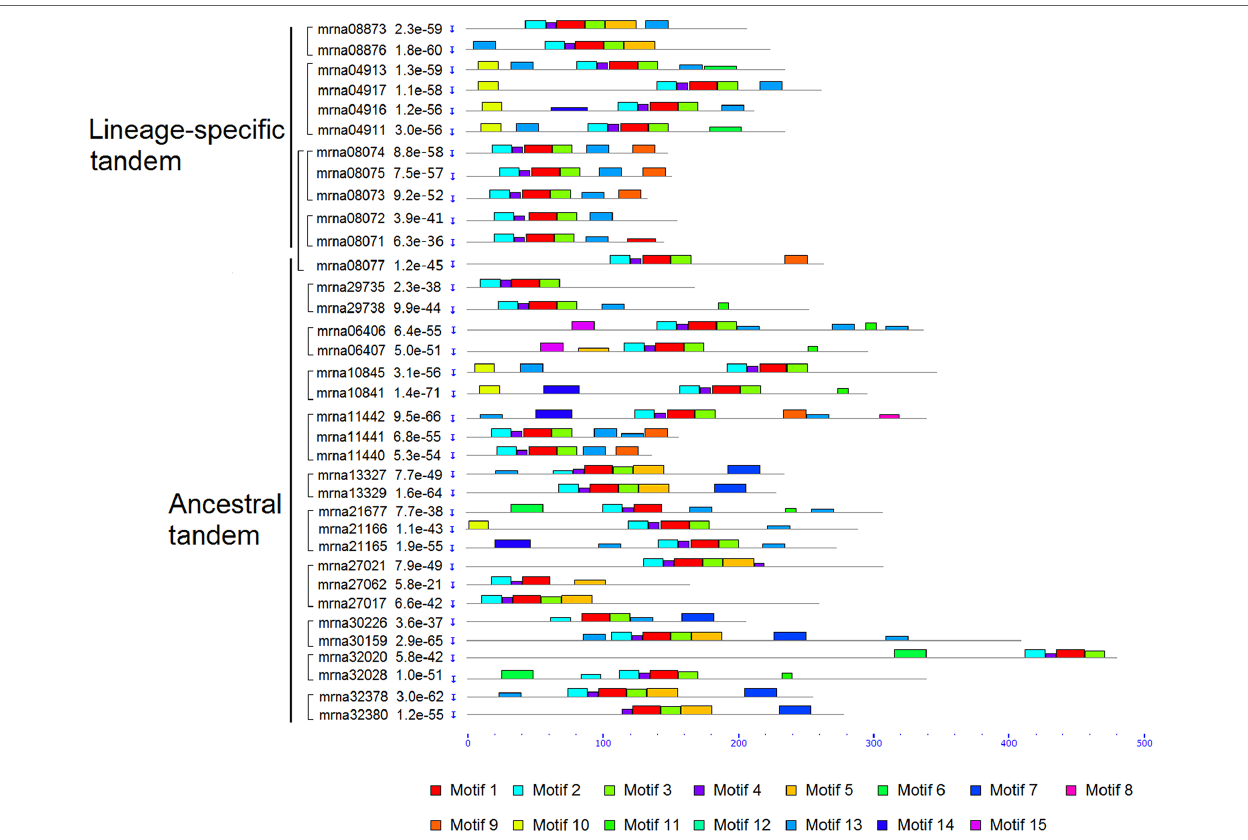
FIGURE 3 | Schematic diagram of amino acid motifs of tandem FveERF proteins. Motif analysis was performed using MEME5.0.1 as described in the Materials and Methods . Proteins whose genes located in the same tandem repeat are grouped together. Mrna08077 forms an ancestral tandem repeat with